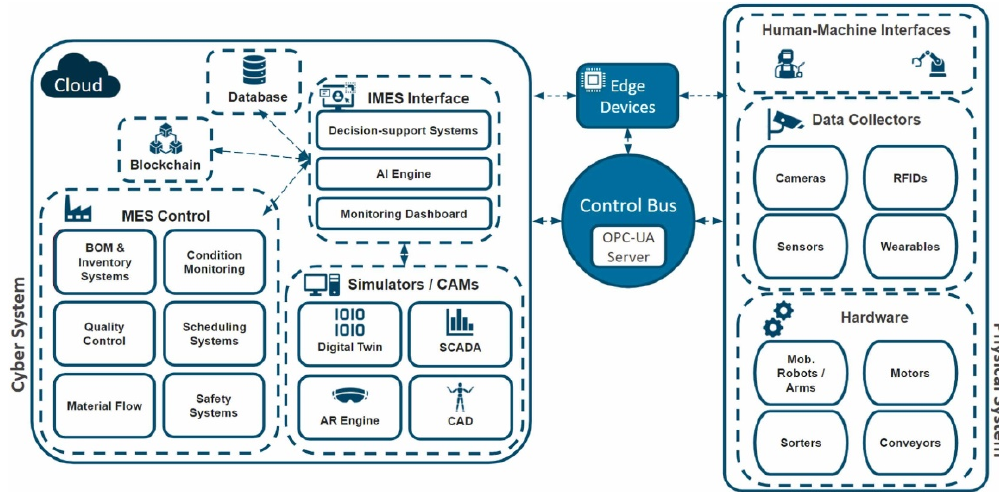
Figure 12. Components of the IMES conceptual model with permission from [78], 2022, Elsevier